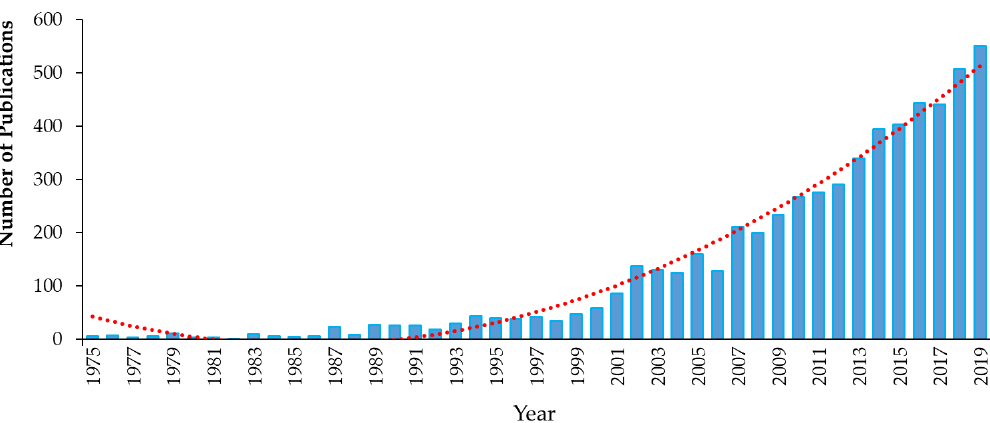
Figure 3. Number of scientific documents on the topic of “triclosan” published for the time period from 1975 to 2019 (data generated from reference [74]).